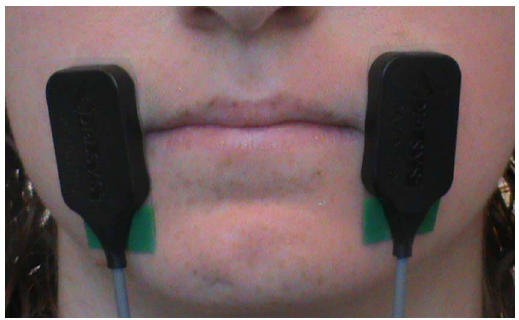
Figure 1. The sEMG signal used to control human-machine- interface operation was obtained from electrodes placed on the left and right orbicularis oris muscles of each participant, who then underwent training phases to become accustomed to controlling the synthesized vowel production caused by activating the left and right